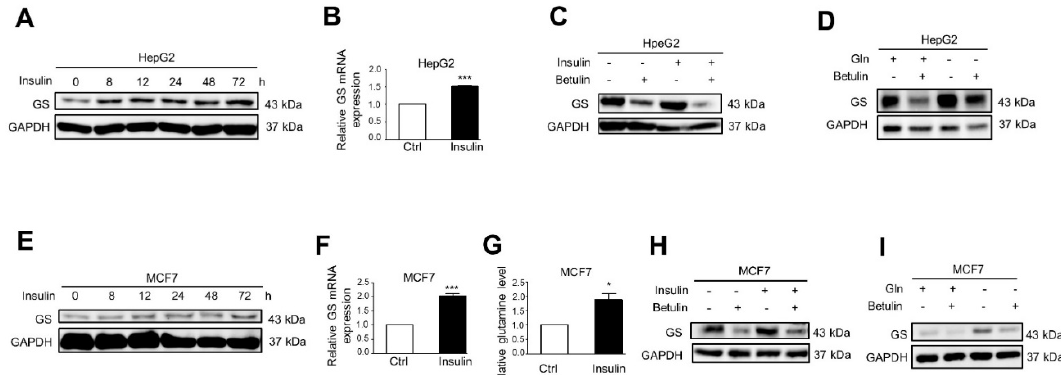
Figure 1. Insulin and glutamine deprivation upregulate GS expression through SREBP1. ( A , B ) HepG2 cells were treated with 200 nM insulin for indicated time periods ( A ) or with 200 nM insulin for 48 h ( B ). ( C ) HepG2 cells were treated with 50 µM SREBP1 inhibitor betulin for 30 min prior to 200 nM insulin treatment for 48 h. ( D ) HepG2 cells were treated with 50 µM SREBP1 inhibitor betulin for 30 min prior to glutamine deprivation for 24 h. ( E , F ) MCF7 cells were treated with 200 nM insulin for indicated time periods ( E ) or with 200 nM insulin for 48 h ( F ). ( G ) MCF7 cells were treated with 200 nM insulin for 72 h followed by intracellular glutamine quantification. ( H ) MCF7 cells were treated with 50 µM SREBP1 inhibitor betulin for 30 min prior to 200 nM insulin treatment for 48 h. ( I ) MCF7 cells were treated with 50 µM SREBP1 inhibitor betulin for 30 min prior to glutamine deprivation for 24 h. Cell lysates were analyzed by Western blot with specified antibodies or qRT-PCR with specific primers. Data represent means plus SEM. * p < 0.05 and *** p < 0.001.